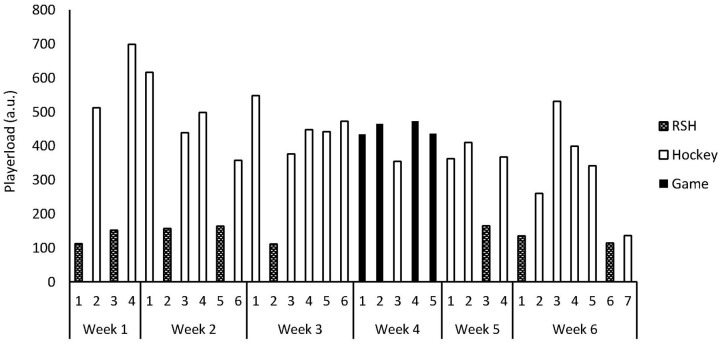
Squad average Playerload load across the 6-week training period. Activities are categorized as repeated sprinting in hypoxia (RSH), on-field hockey training (Hockey), and international hockey matches (Game).